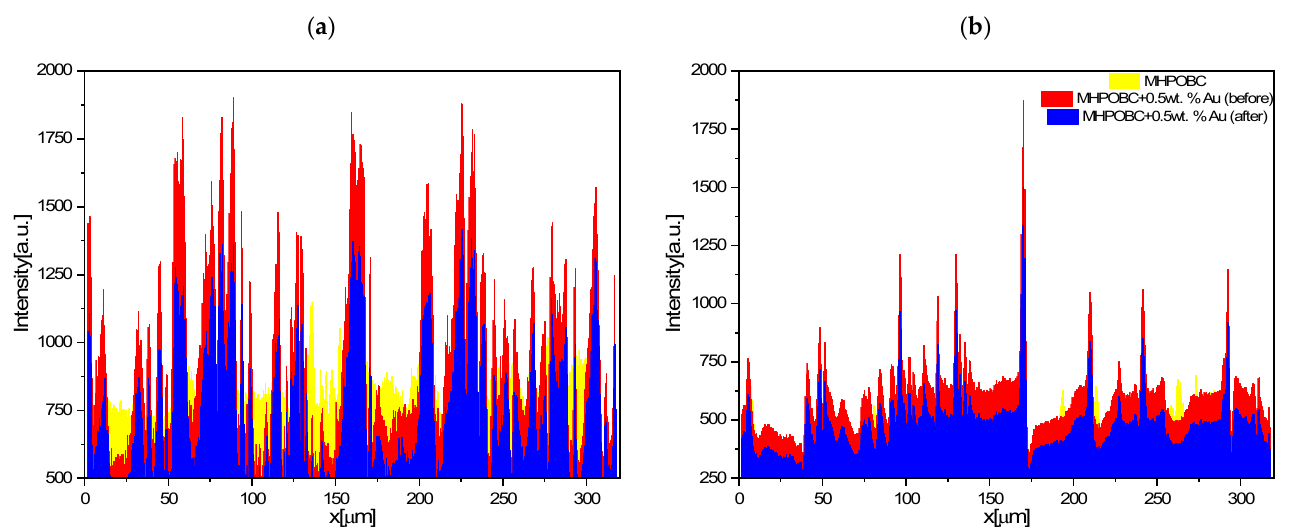
Figure 6. Fluorescence intensity versus horizontal dimension of the samples: pure MHPOBC liquid crystal ( a , d ), MHPOBC doping with 0.5 wt.% Au NPs before ( b , e ) and after ( c , f ) photobleaching procedure for detection in the blue and green light wavelength ranges, respectively. The third dimension represents successive scans taken as a function of cell thickness.